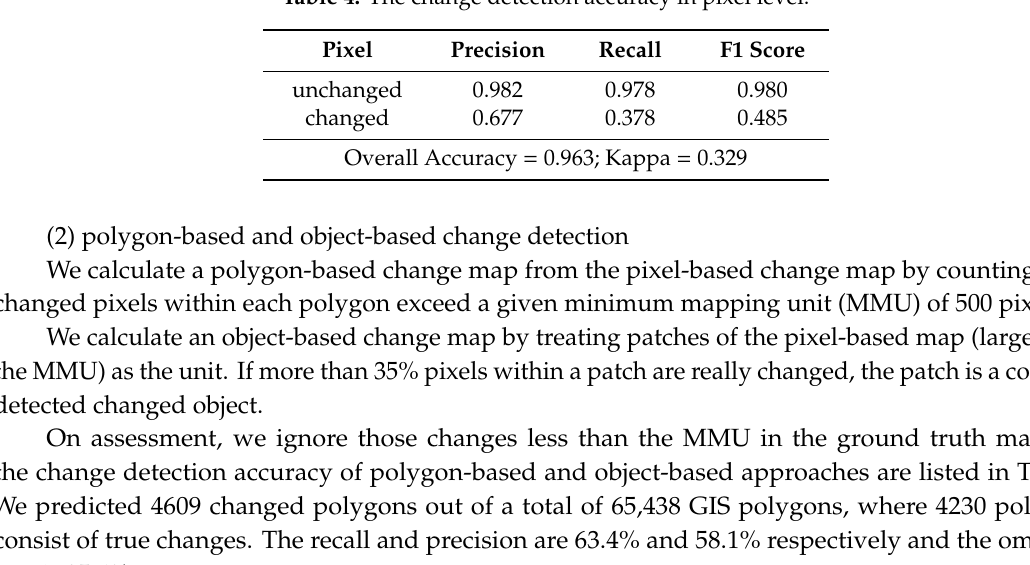
Table 5. The change detection accuracy assessed on polygon and object level. GT indicates those truly changed polygons / objects retrieved from the di ff erence map between 2014 and 2017 GIS maps. Type Number GT Predicted Recall Precision Omission F1 Polygon 65,438 4230